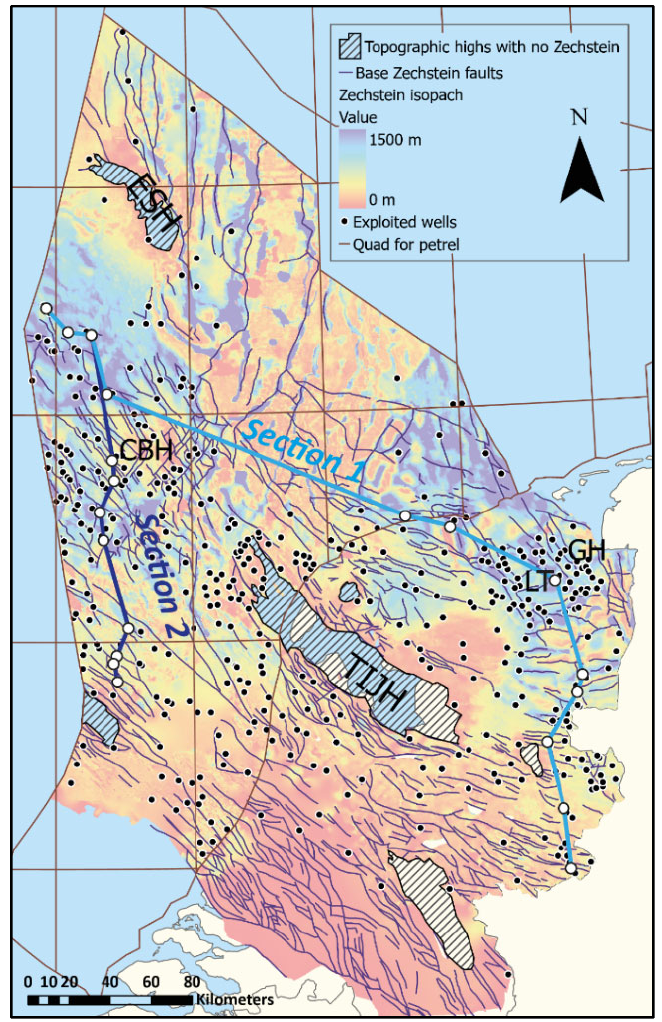
Figure 2. Isopach map of the Zechstein (after [5]) with the localization of the exploited wells in the course of this study and the performed correlative cross ‐ sections (Sections 1 and 2). Capital letters refer to structural domains, CBH: Clever Bank High, LT: Lawerszee Trough, GR: Groningen High, TIJH: Texel ‐ Ijsselmeer High, ESH: Embow Spit High.